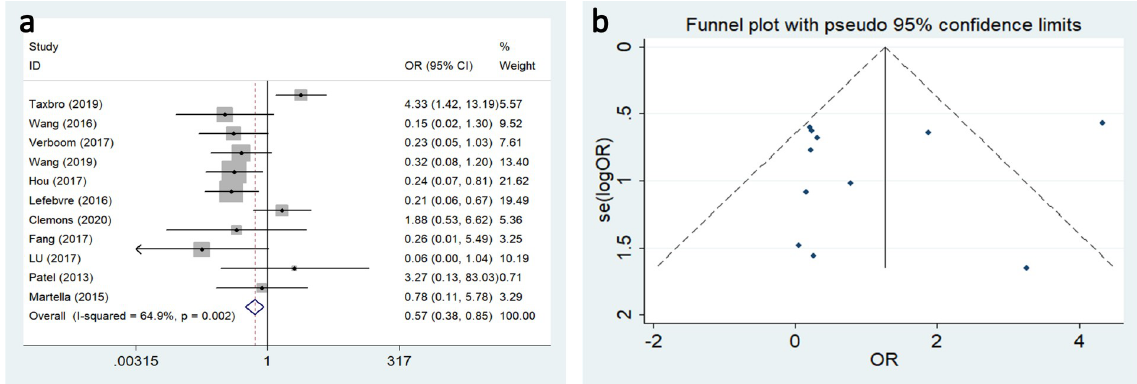
Fig 3. Forest plots and funnel plot for publication bias test for the comparing the occlusion between TIVAP and PICC.